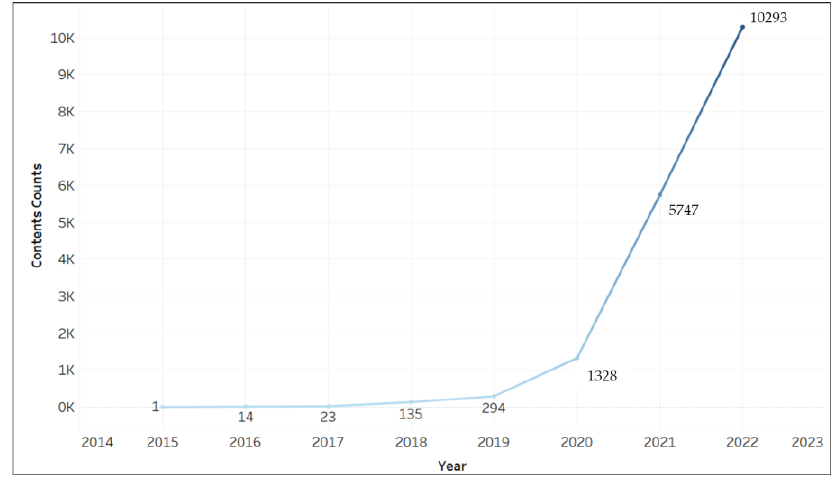
Figure 1. Instagram posts on construction health and safety by year.